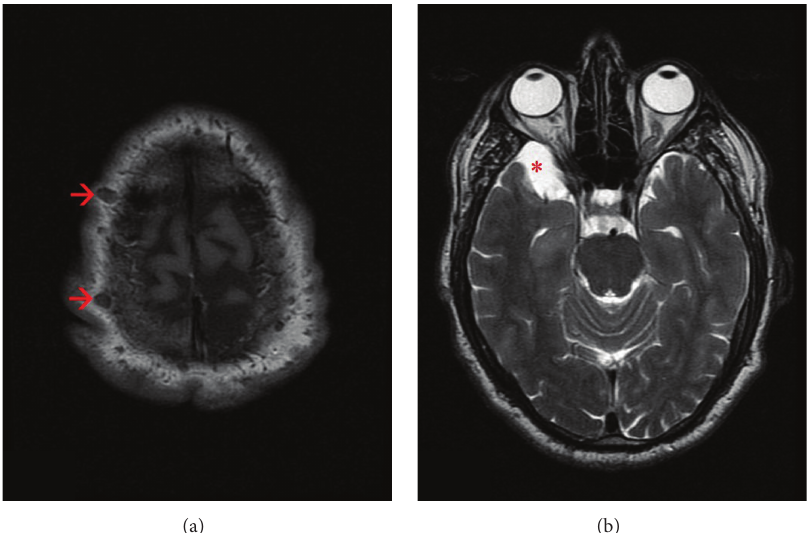
Figure 2: Cranial MRI findings. (a) Axial T1-weighted image depicts multiple neurofibromas on the scalp (marked by arrows). (b) Axial T2-weighted image demonstrates an arachnoid cyst in the right anterior temporal lobe (marked by an